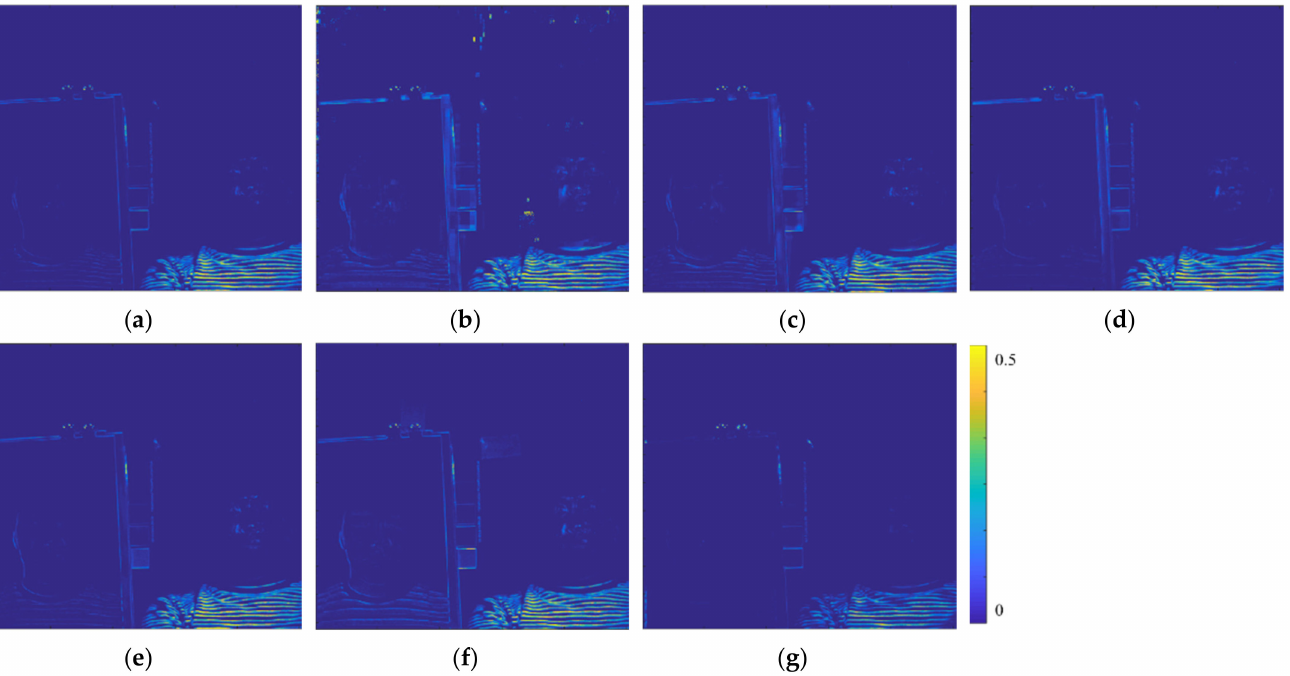
Figure 3. Residual information of CAVE dataset with simulated multispectral images. ( a ) results of GSA; ( b ) results of SFIMHS; ( c ) results of GLPHS; ( d ) results of CNMF; ( e ) results of ICCV15; ( f ) results of HySure; ( g ) ours